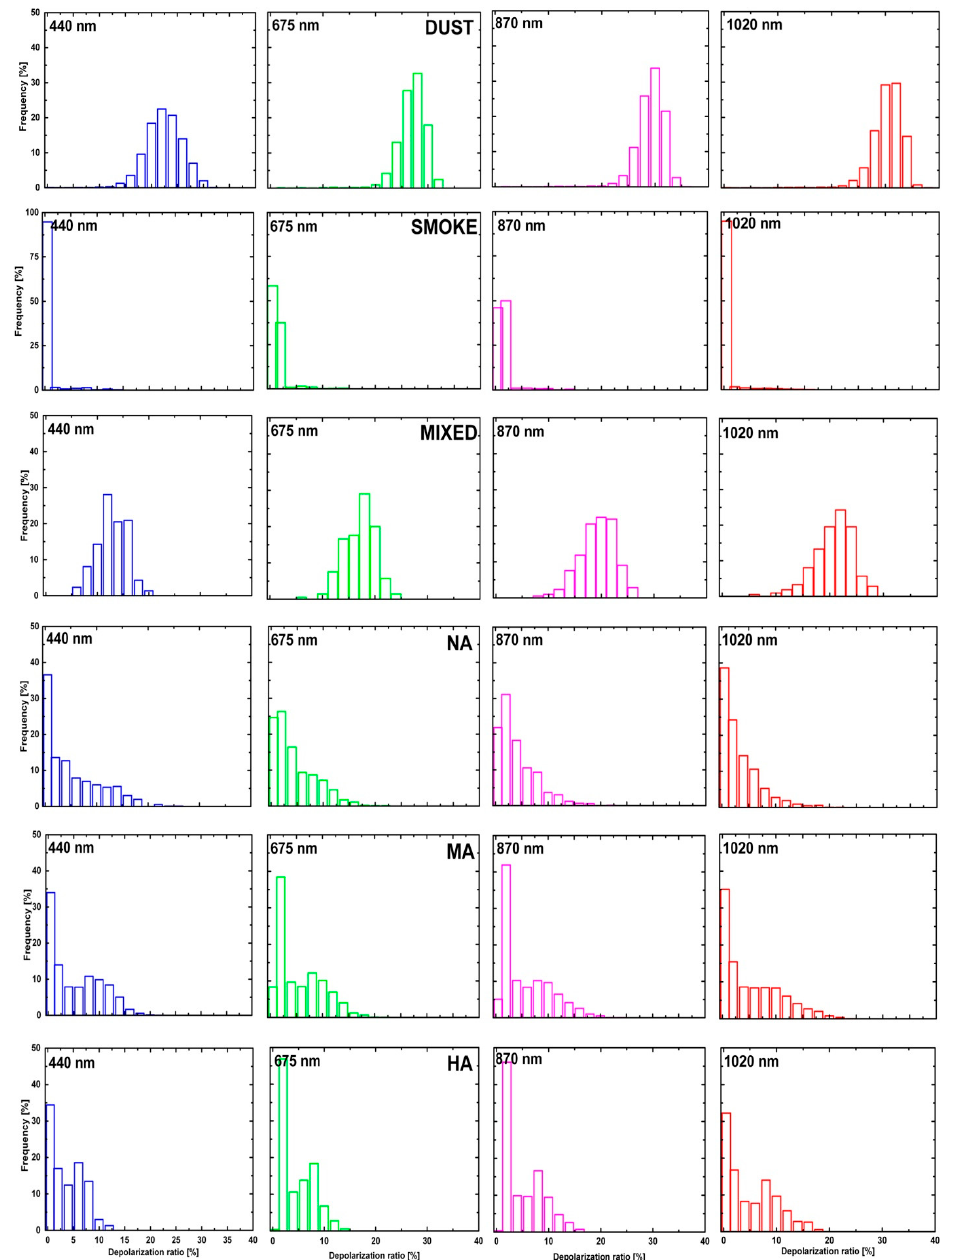
Figure 4. Frequency distribution of the spectral depolarization ratio for dust, smoke, mixed, non-absorbing (NA), moderate-absorbing (MA) and high-absorbing (HA) pollution particles at 440 (blue), 675 (green), 870 (magenta) and 1020 (red) nm wavelengths, respectively. Statistics for the histograms are provided in Table 3.